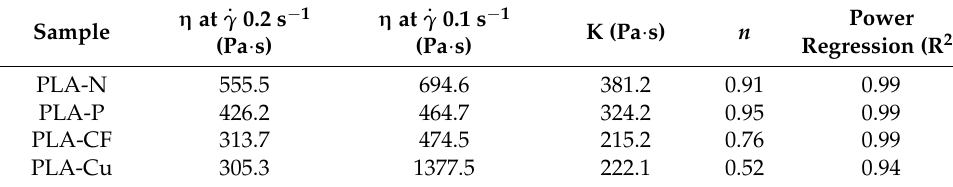
Table 3. Complex viscosity and power–law index of PLA filaments at 210 ◦ C.